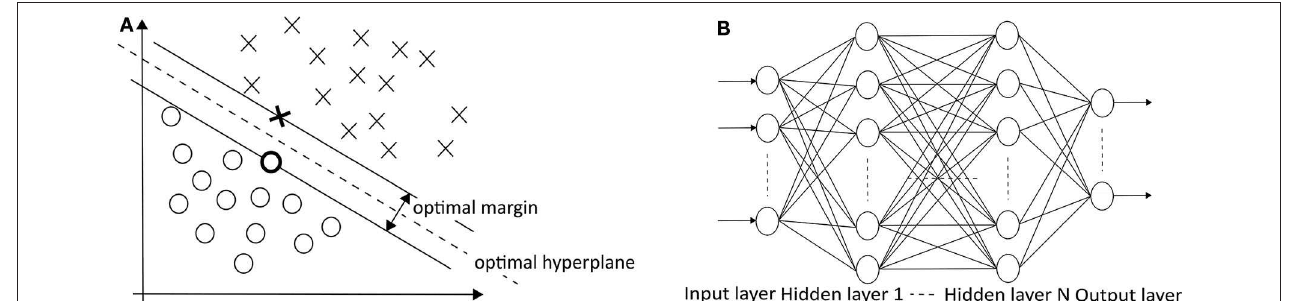
FIGURE 5 | (A) SVM (O: positive cases, X: negative cases) (25) and (B) MLPNN (113) architectures.